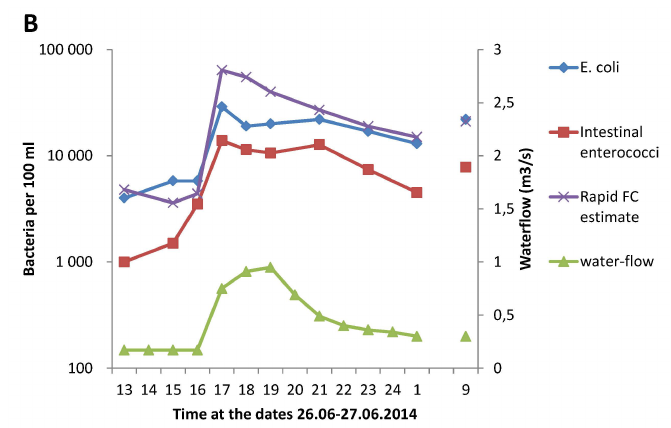
Figure 1. Hoffselva ( A ) and Mærradalsbekken River ( B ) before, during and after heavy rainfall 26 June 2014. Local heavy precipitation was observed in the area (average for the 4 nearest weather stations: no precipitation occurred on the days before 15 pm on 26 June 2014, 25 mm occurred between 15 and 18 pm and a further 4 mm occurred before 9 am on 27 June 2014.